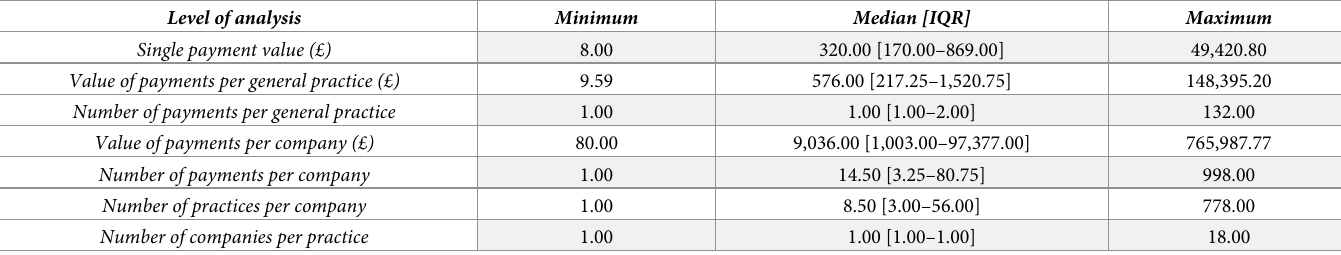
Table 1. Summary of drug company payments to general